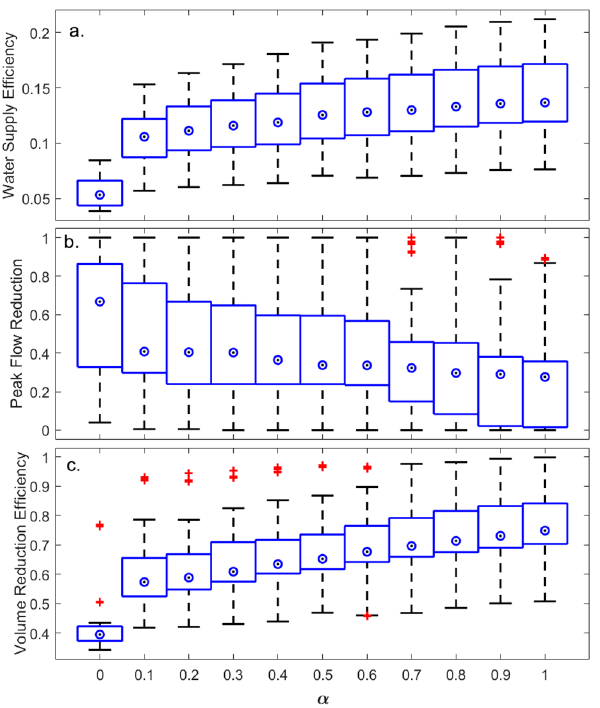
Figure 6. WSE, PFR, and VRE as a function of release parameter, α , for the modeled building with a 20 m 3 tank. WSE and VRE decline as more water is released from the tank (smaller α ), while PFR increases as more storage is available for incoming roof runoff. ( a ) WSE, ( b ) PFR, ( c ) VRE.